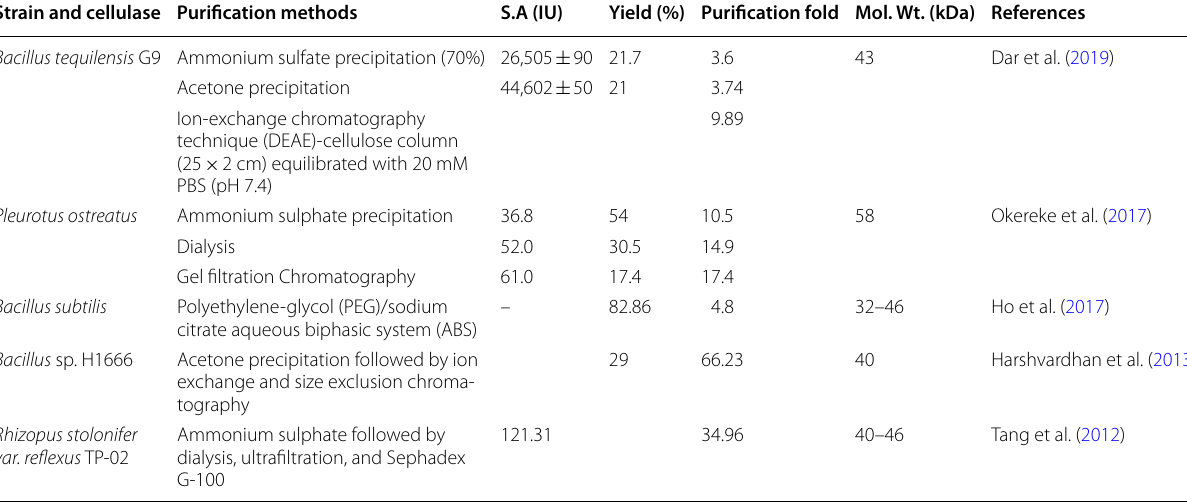
Table 3 Exploration of recent purification method for enhanced cellulase activity Strain and cellulase Purification methods S.A (IU)